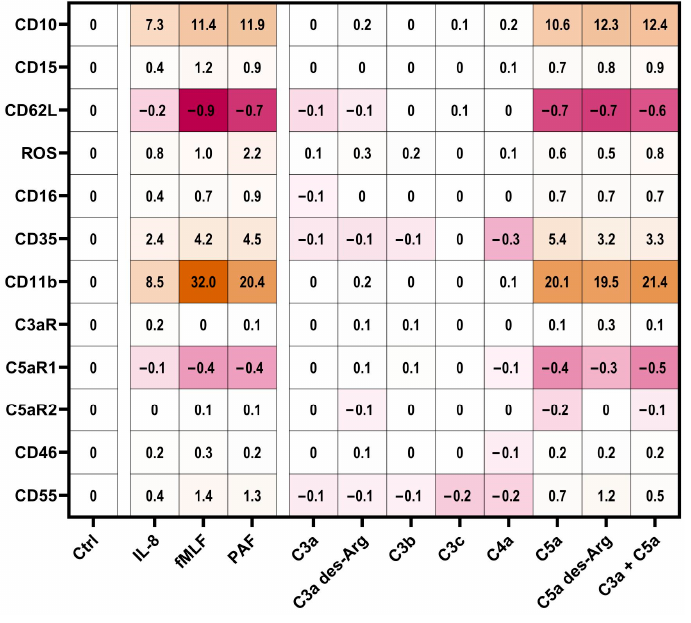
Figure 6. Summary of the neutrophil response. Results report the median change of stimulated cells normalized to the respective ctrl (=0). Cellular response in the form of an upregulation is indicated by different shades of orange and downregulation is indicated by different shades of pink. The following concentrations were used: 10 nM C5a, 10 nM C5a des-Arg, 10 µM fMLF, 50 ng/mL IL-8, 100 nM C3a, 100 nM C3a des-Arg, 100 nM C3b, 100 nM C3c, or 100 nM C4a. n = 6–8.